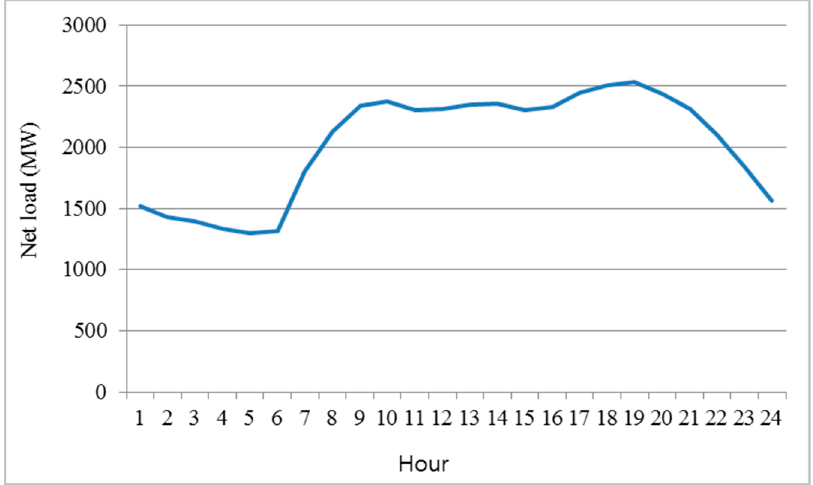
Figure 4. Forecast net load profile.